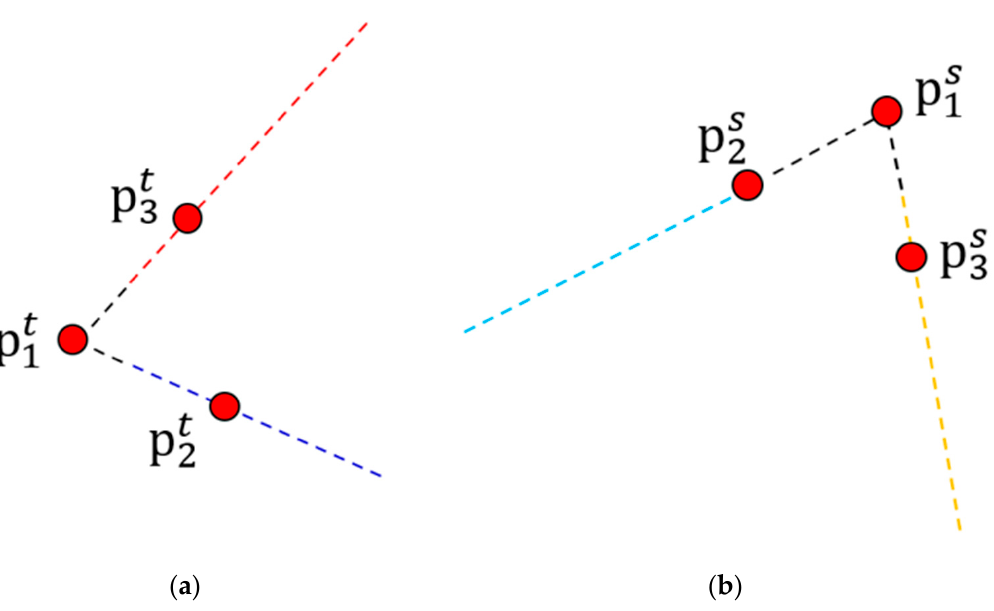
Figure 18. Point cloud registration diagram based on 2D line segment. ( a ) Target point cloud segment. ( b ) Point cloud line segments to be registered.